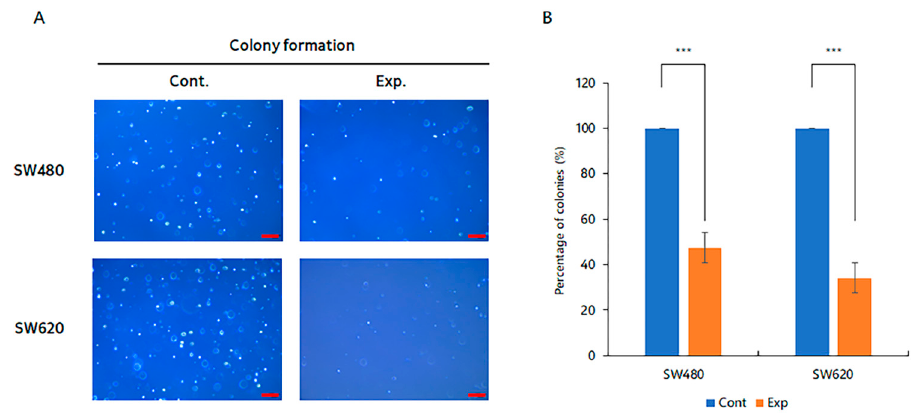
Figure 5. Tumorigenicity confirmation test by siTSPAN5. ( A ) Evaluation of the tumorigenicity of SW480 and SW620 cells. (Scale bar 100 µ m). ( B ) Graph of the relative tumorigenicity of each cell line (*** p <